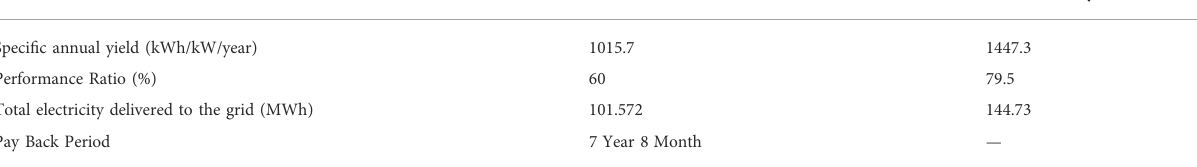
TABLE 7 Signi fi cant outcomes from the